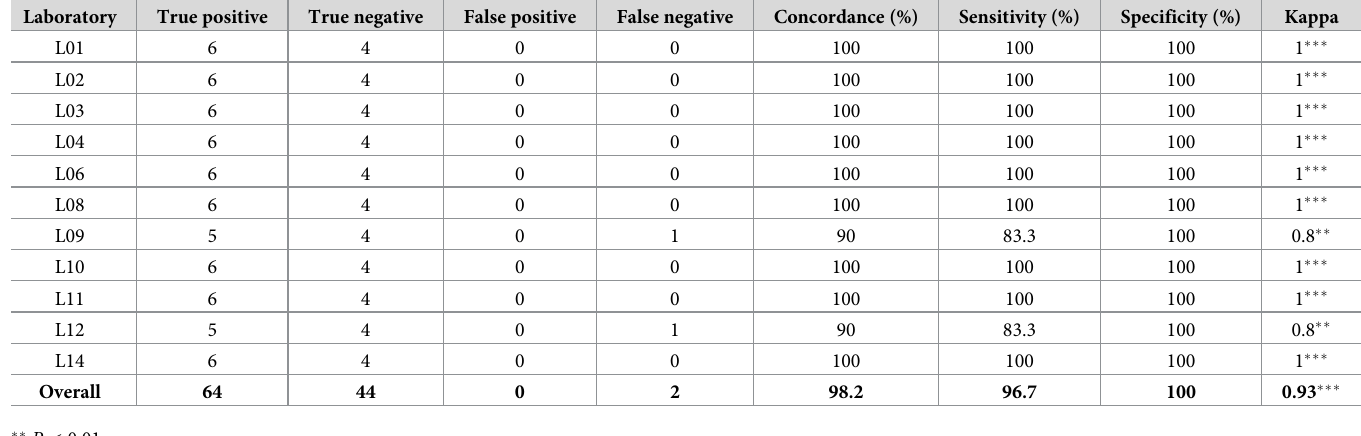
Table 3. Conventional RT-PCR results by laboratory and statistical analyses of agreement. The concordance, specificity, sensitivity and K coefficient with p-value were calculated per each laboratory. Eleven laboratories (out of fourteen) submitted results for this part of the PT. Laboratories L03, L07 and L13 did not submit any results for the molecular test.